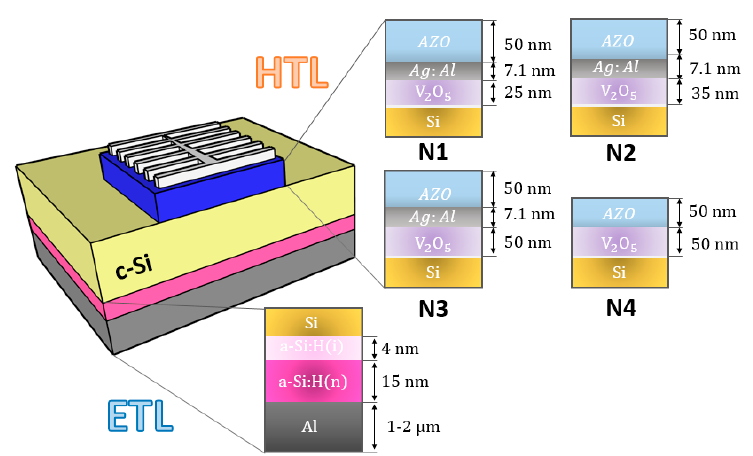
Figure 1. Schematic of a solar cell based on n-type c-Si, with different configurations studied in this work. The multi structured layers of V 2 O 5 /Ag:Al/AZO act as both transparent conducting and hole-selective electrode.